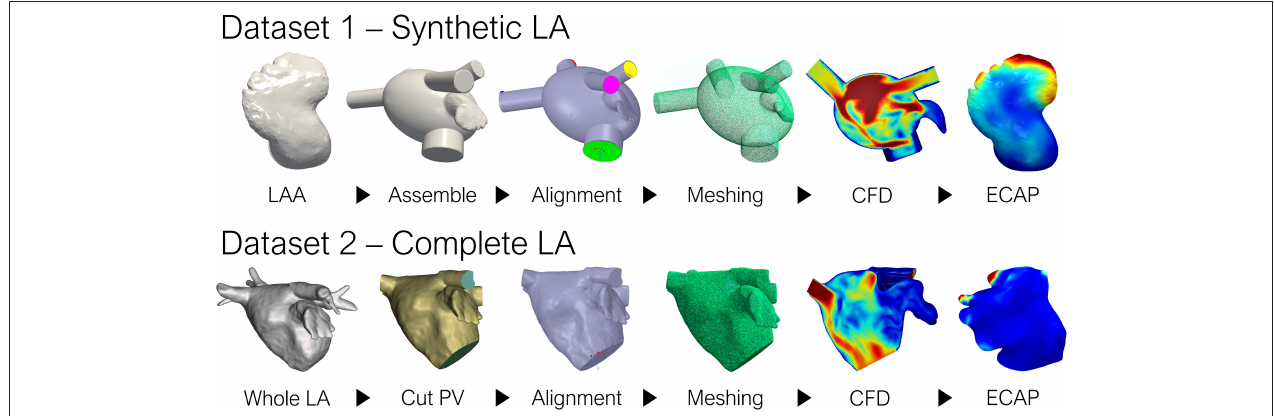
FIGURE 1 | Pipeline to generate the ground truth ECAP maps for the two datasets. LA, left atrium; LAA, left atrial appendage; PV, pulmonary veins; CFD, computational fluid dynamics; ECAP, endothelial cell activation